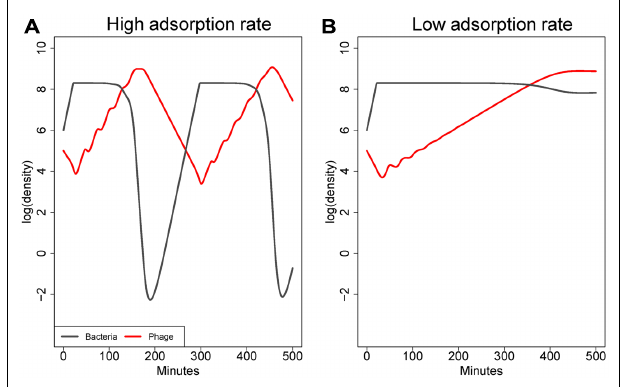
FIGURE 1 | Co-dynamics of bacteria and phage in a model with a constant washout rate. (A) shows dynamics with an adsorption rate of 10 − 9 mL/min, (B) with an adsorption rate of 10 − 10 mL/min. Parameters are otherwise the same between (A) and (B) .The higher adsorption leads to better killing of the cells. As is typical in these models when adsorption rate is high, densities fluctuate because phage decline (due to washout) after cell density has been depressed, and once phage density declines, bacterial densities rebound until phage catch up. However, with a mere 10-fold decline in adsorption rate, phage can grow but fail to depress bacterial densities substantially.The model is based on differential equations similar to those in Bull etal. (2014).